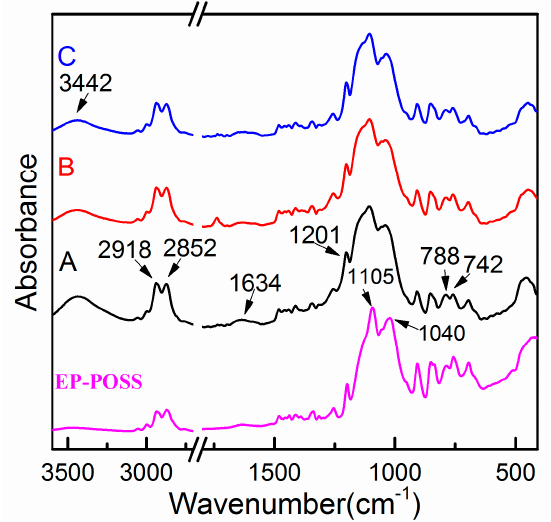
Figure 2. Infrared spectrum of EP-POSS film modified by nanoparticles. A-EP-POSS/SiO 2 /graphene, B-EP-POSS/ZnO/graphene, C-EP-POSS/graphene.